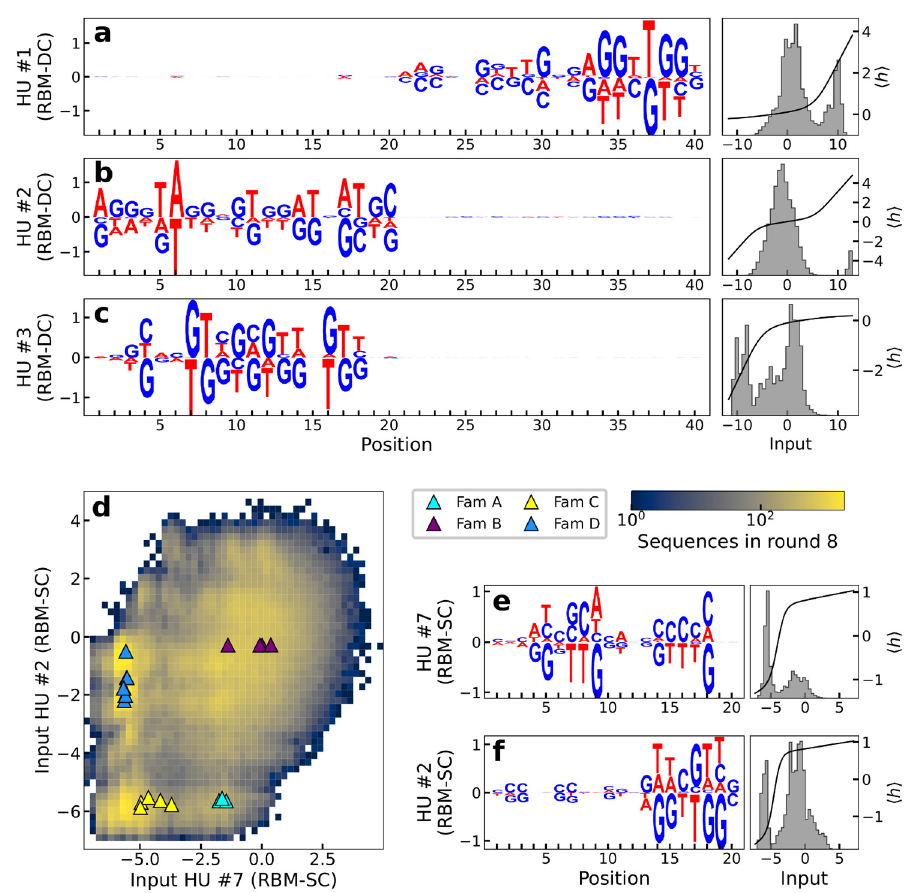
Fig 4. Weights learned by the RBMs have biological interpretations. a-c : Left: logos of three weights μ = 1, 2, 3 with largest Frobenius norms for RBM-DC trained on round 8 aptamer data; Right: histograms of the inputs I μ = ∑ i w μi ( s i ) (where w is the weight of the connection between hidden unit μ and visible unit i for nucleotide s μi corresponding hidden units for the sequences s in the dataset (gray) and average activity (black). d : The four families identified in [41] are separated in different clusters in the two-dimensional subspace spanned by the inputs to hidden units 2 and 7 of RBM-SC (trained on loop subsequences at round 8). e, f : Logo, distribution of inputs and average activity of the same hidden units as in panel